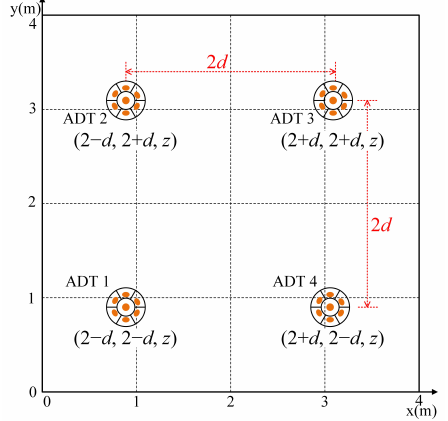
Figure 3. Placement of four ADTs in the ceiling.